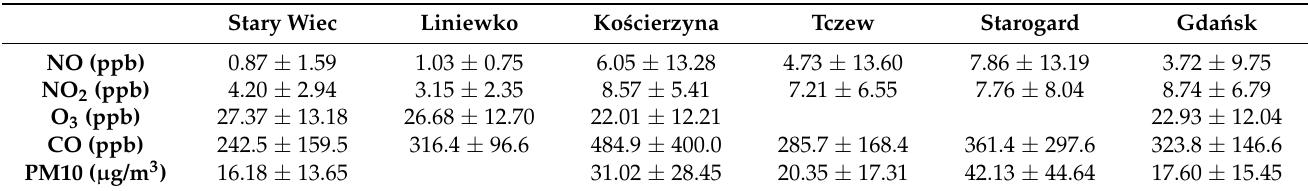
Table 2. Statistics for air pollution data from Stary Wiec and nearby rural and urban stations, based on hourly means, collected from August 2015 to July 2017. Mean values for this period, together with standard deviations (1 σ ), are